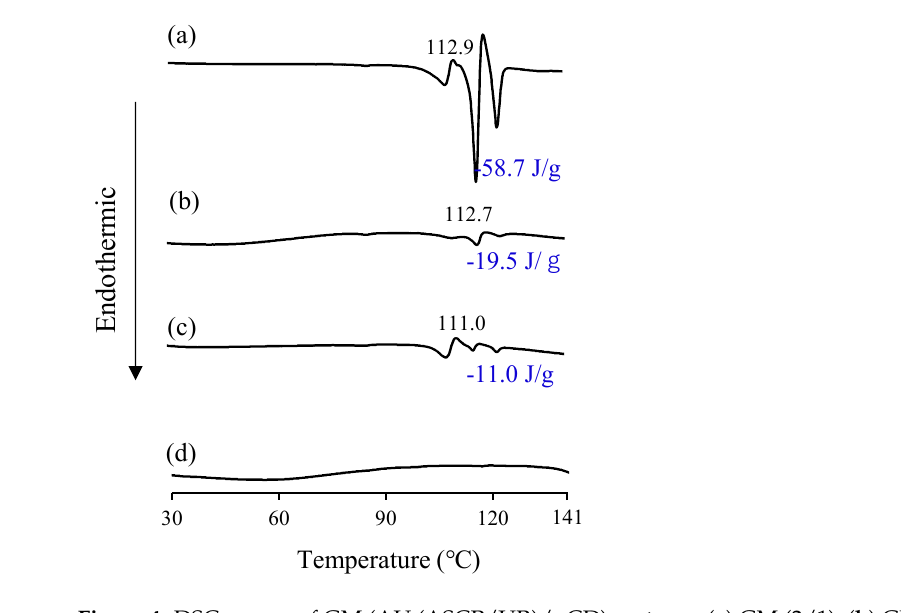
Figure 4. DSC curves of GM (AU (ASCP/UR)/ γ CD) systems. ( a ) GM (2/1), ( b ) GM (1/1), ( c ) GM (2/3), ( d ) GM (1/2)